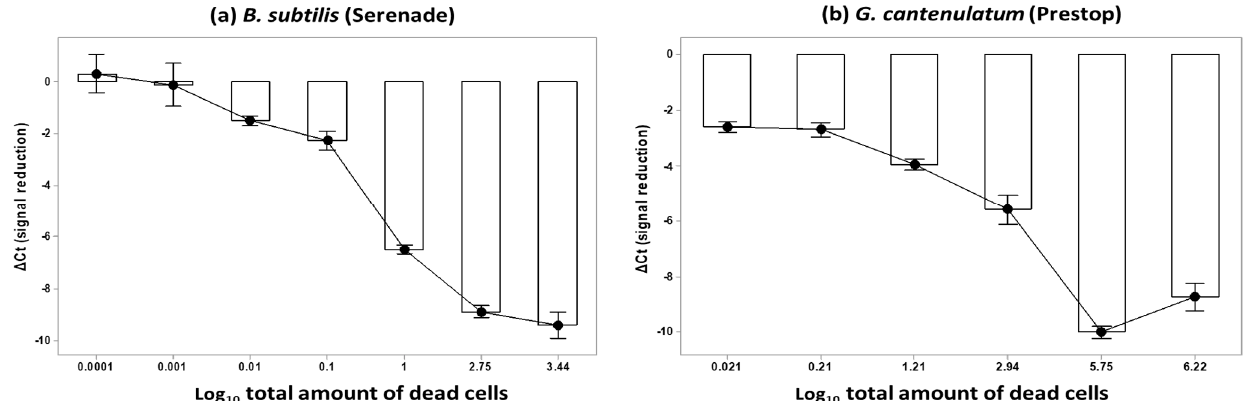
Figure 6. ( a ) Interval plot of overall mean ∆ Ct (signal reduction) to overall mean log 10 total dead cell number of B. subtilis; ( b ). The interval plot of overall mean ∆ Ct (signal reduction) to overall mean log 10 total dead cell number of G. catenulatum. Log 10 mean numbers of total dead cells for all treatments were determined from the difference between total cell counts using a haemocytometer and the viable plate counts. The bars represent the standard error of the means.